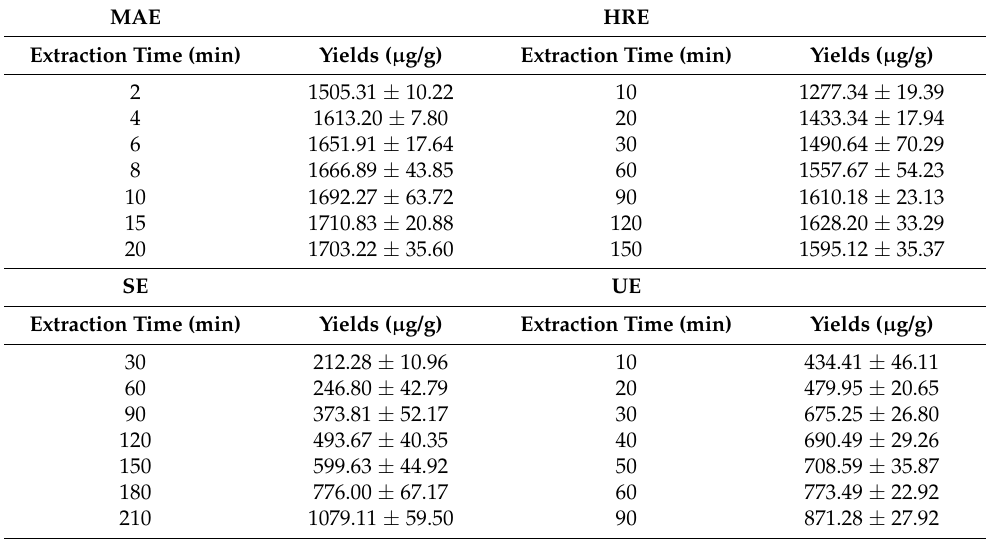
Data are expressed as the mean value ( ± SD) of three independent experiments.